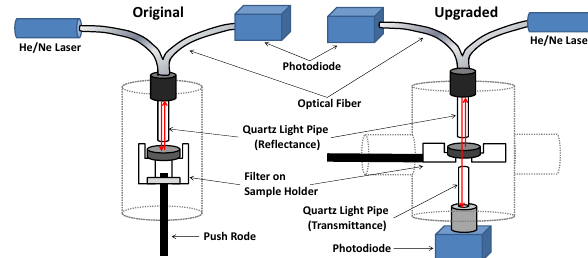
Fig. 2. Schematics of optical monitoring system in the original (left) and upgraded (right) carbon instrument. The laser beam is directed to the sample through a coaxial optical fiber and a quartz light pipe (perpendicular and ∼ 2mm to the filter sample) by which the re- flected light is acquired. The sample holder is redesigned in the up- graded instrument to allow collection and detection of the transmit- ted light. The dashed boxes illustrate the heating zone for thermal